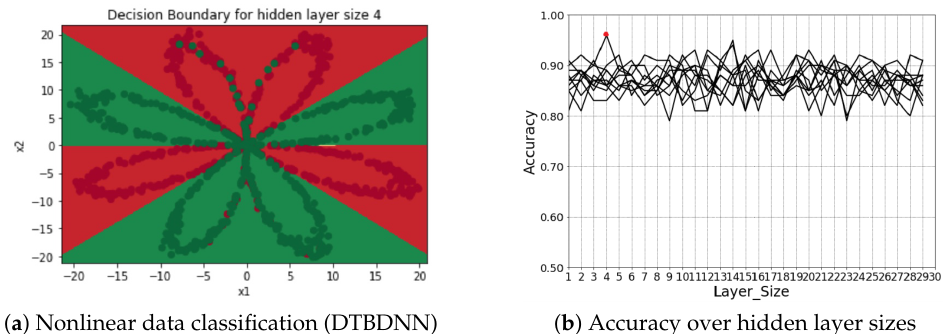
Figure 6. Accuracies of the DTBDNN model to classify nonlinear